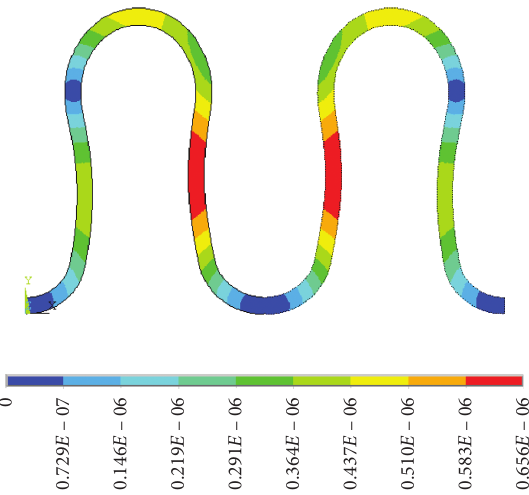
Figure 14: Deformation distribution at air outlet and gas inlet side considering thermal stress (m).